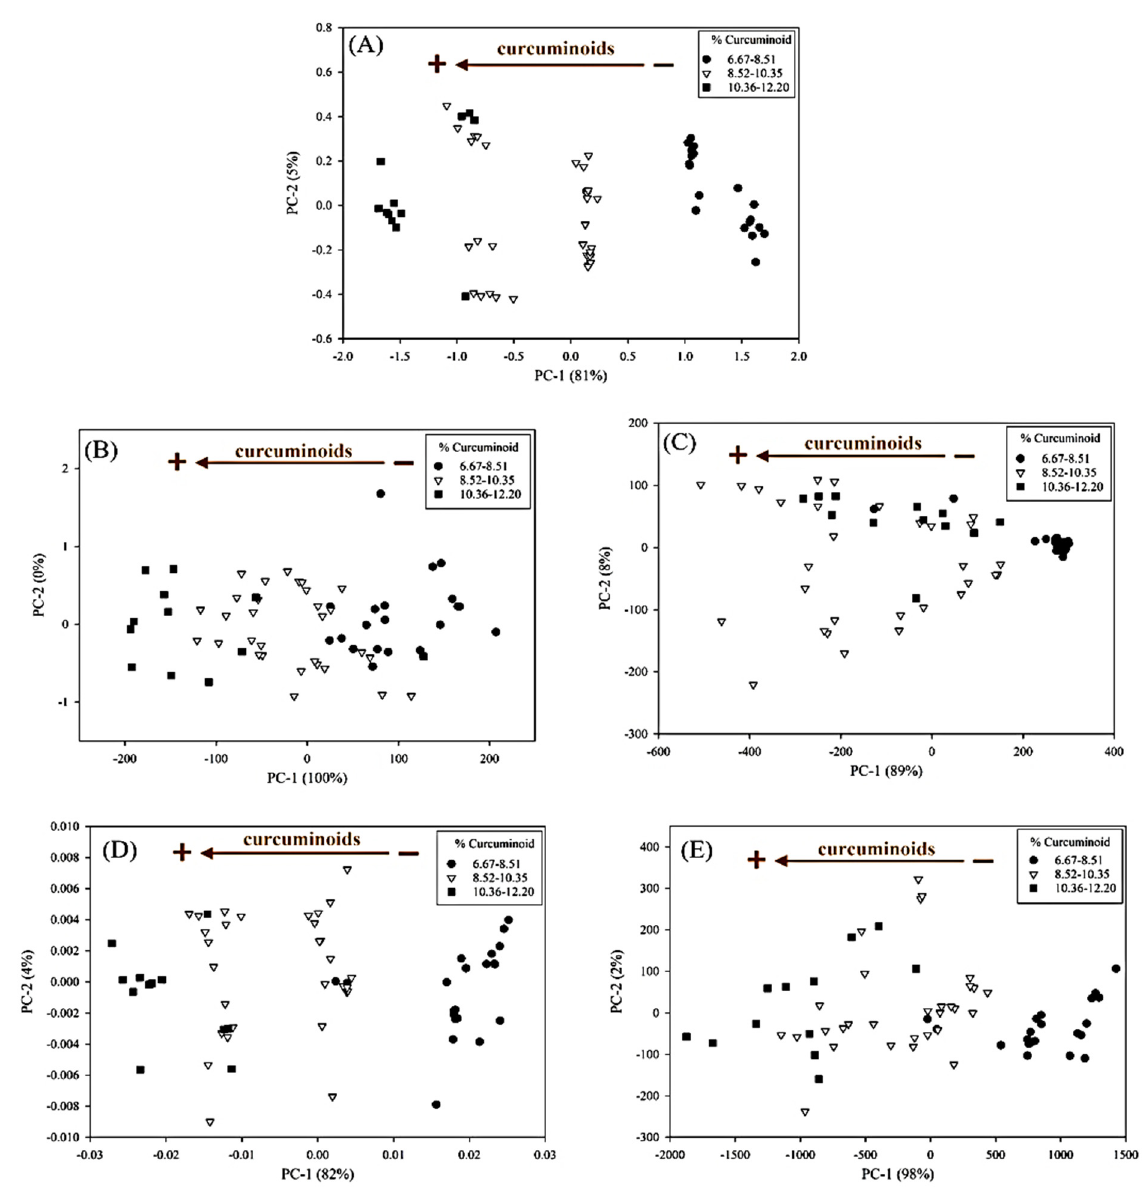
Figure 3. PCA of the pre-processed data using ( A ) SNV+2D of benchtop NIR spectral range of 1854–2260 nm, ( B ) OSC with 2 factors of benchtop FT-IR spectral range of 766–1687 cm − 1 , ( C ) smooth- ing + BLC + OSC with 1 factor of benchtop Raman spectral range 840–1799 cm − 1 , ( D ) SNV + 2D